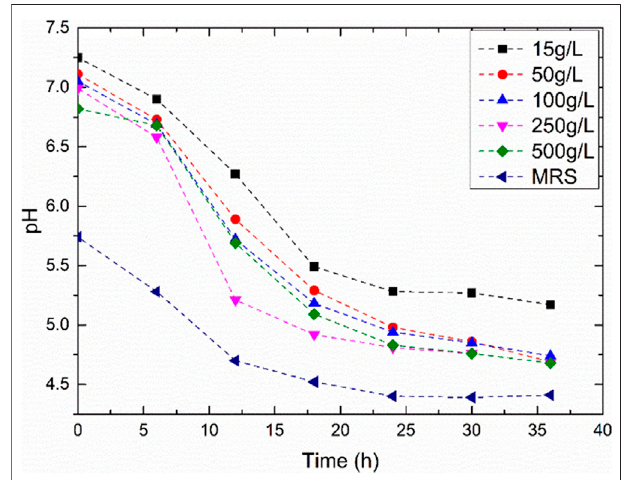
FIGURE 2 | Bacterial growth in media with different sucrose concentrations.